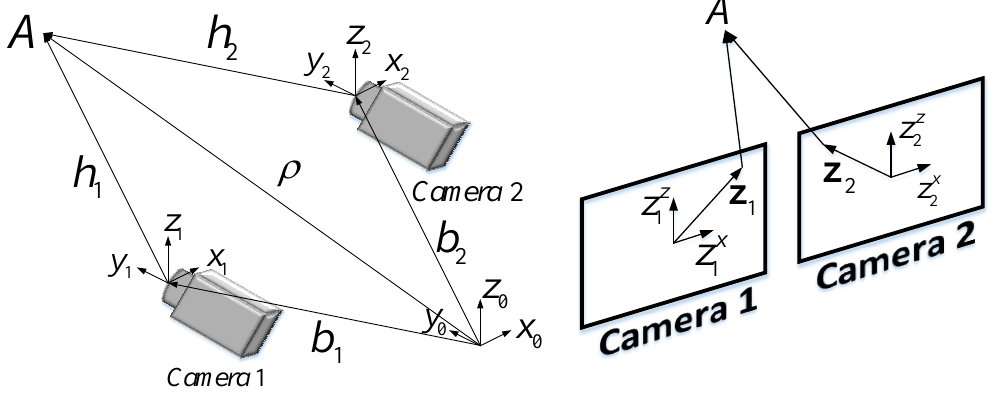
Figure 1. The geometry of